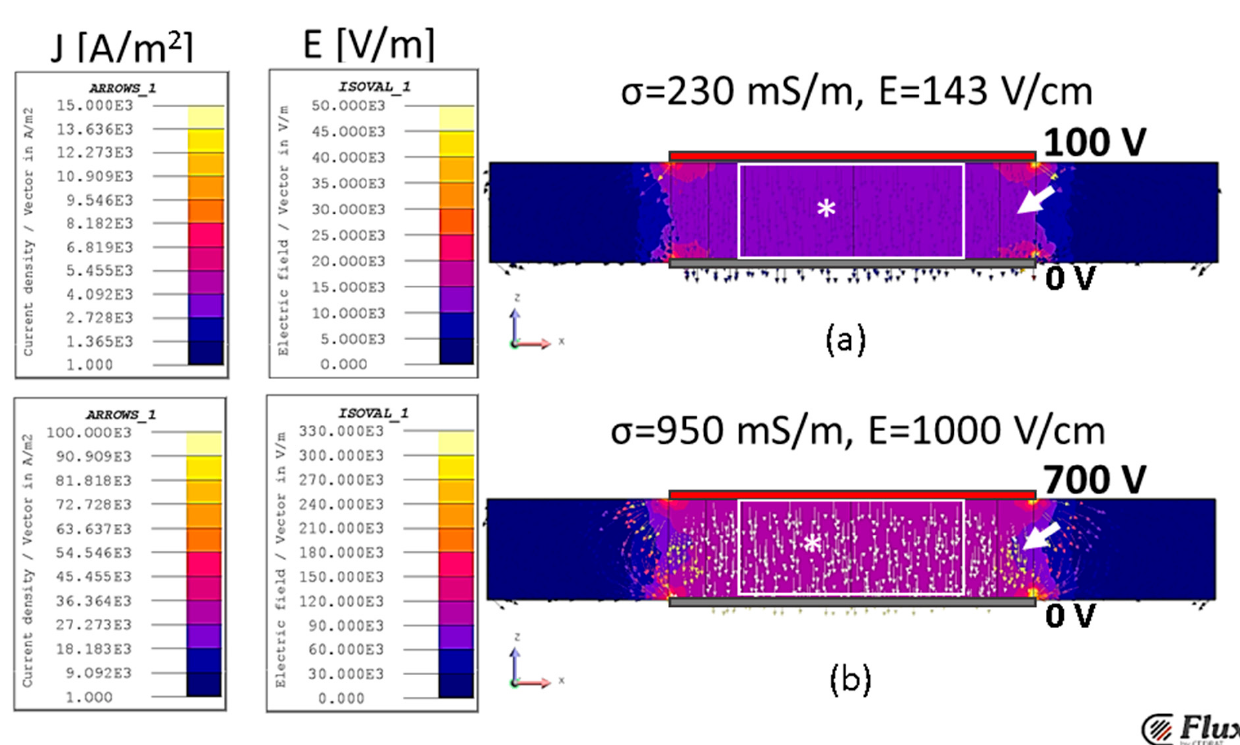
cube-shape model, the electric field distribution is more uniform along all the samples